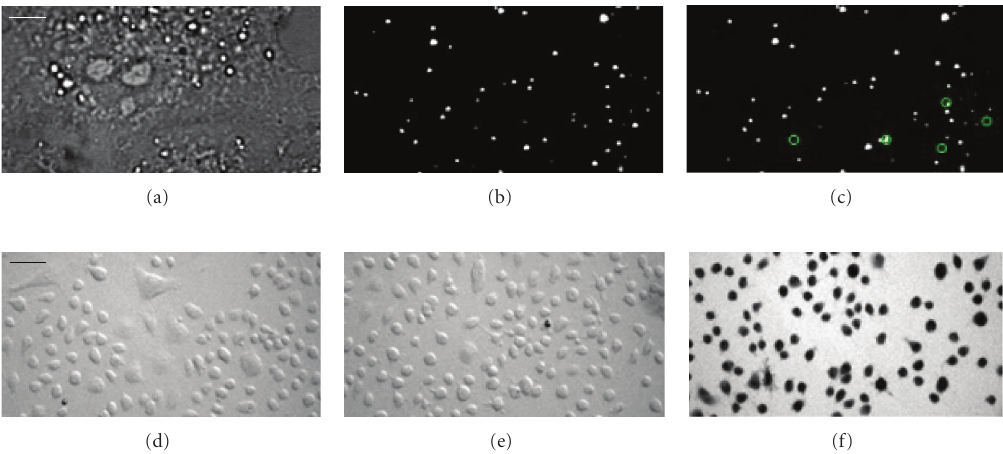
Figure 3: Evaluation of cytoplasmic nanoparticle loading in live cells by osmotic lysis of pinosomes. COS-7 cells were incubated in hypertonic solution (10 minutes, 37 ◦ C, Invitrogen I-14402) for pinocytic loading of QD565ITK nanocrystals (NCs, Quantum dot corporation). Shifting to hypotonic culture medium caused the osmotic lysis of the internalized pinosomes and release of NCs into the cytoplasm. (a) Bright-field image at × 100 magnification. Scale bar for (a) to (c): 4 μ m. (b)–(c) Epifluorescence images from a time-resolved image stack of the same cell. Green circles identify individual NCs that intermittently changed from ON to OFF state (blinking) between frame 250 (b) and 253 (c). Cell viability following loading was tested using the trypan blue exclusion assay at low magnification, × 10. Osmotic shock without (d) and with 1 nM QD565ITK nanocrystals in the extracellular fluid (e) did not compromise cell viability. (f) In contrast, adding ethanol reliably killed cells as reported by the dark trypan blue labelling. Scale bar for (d) to (f): 40 μ